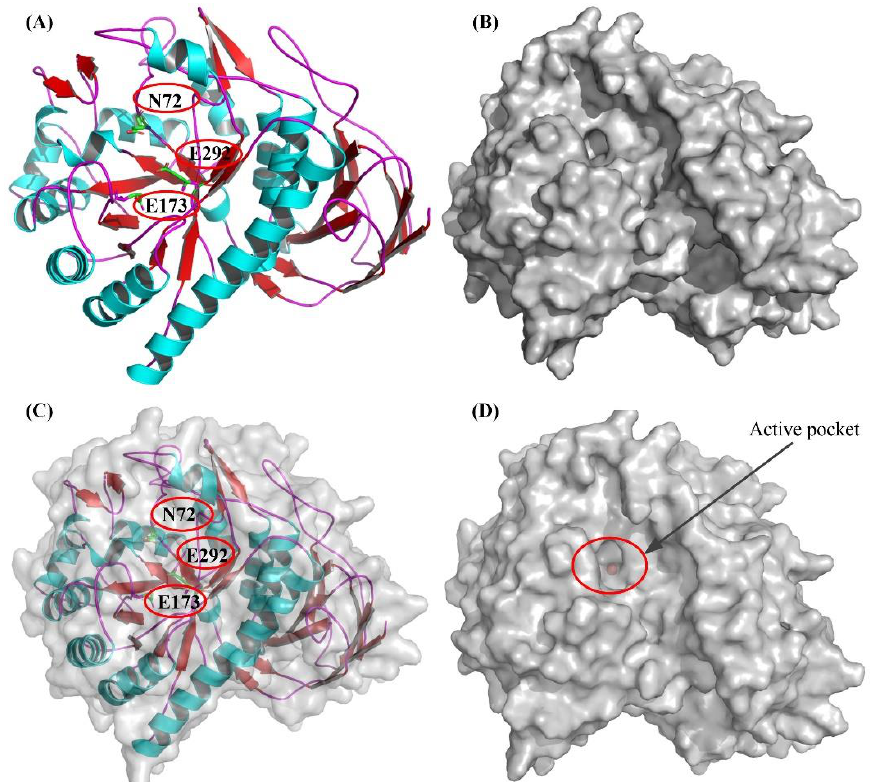
Figure 7. The 3D model of BsAbfA, with location of the deduced catalytic sites indicated. The 3D model of BsAbfA in top view ( A ) and surface view ( B ) was built by comparative modeling using the crystal structure of α - L -arabinofuranosidase Ara51 (PDB code: 5O7Z) from C. thermocellum as a template in the SWISS-MODEL server. The colored segment of the skeleton structure marks the position of β -sheet (red), α -helix (cyan), and loop (purple). The red circles show the active pockets or sites. The active sites of three residues (i.e., N72, E173, and E292) are shown as a stick. ( C ) The top and surface view are shown in overlap form. ( D ) The active pocket is shown in a surface view.